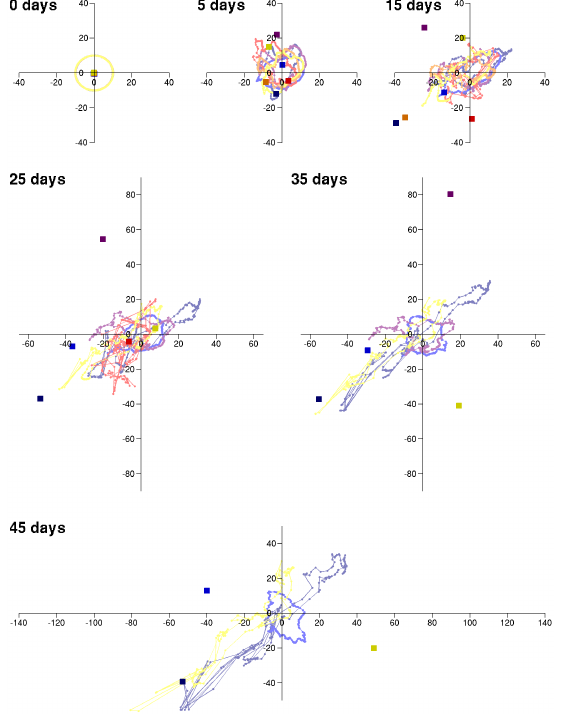
Figure 4. At different moments during the drifter-buoy track, the difference between the drifter path and the corresponding modelled trajectory is shown (as squares, with the different tracks shown in different colours) with, on top of that, the current position of parti- cles released in a circle around the drifter position. The x and y axis represent kilometres of spread. With time, the distance between the actual drifter position and that of the modelled particles increases (as can also be seen in Fig. 3). The spread of particles originally released in a circle around the central particle deforms and expands over time.